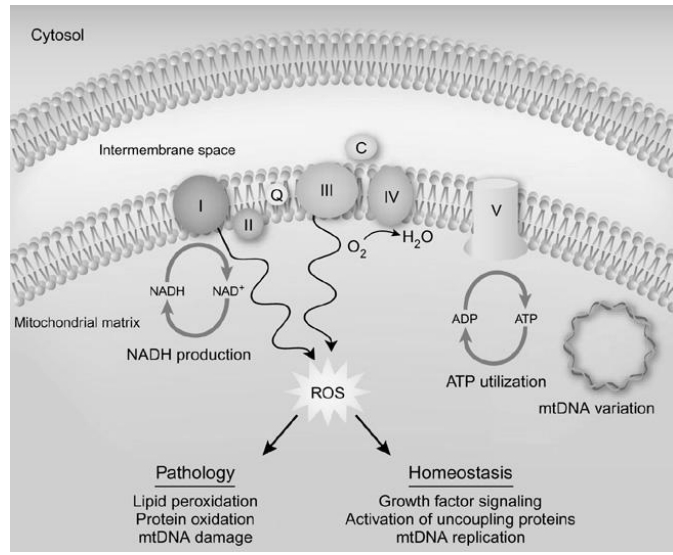
FIGURE 3. Mitochondrial electron transport chain ROS production[32].